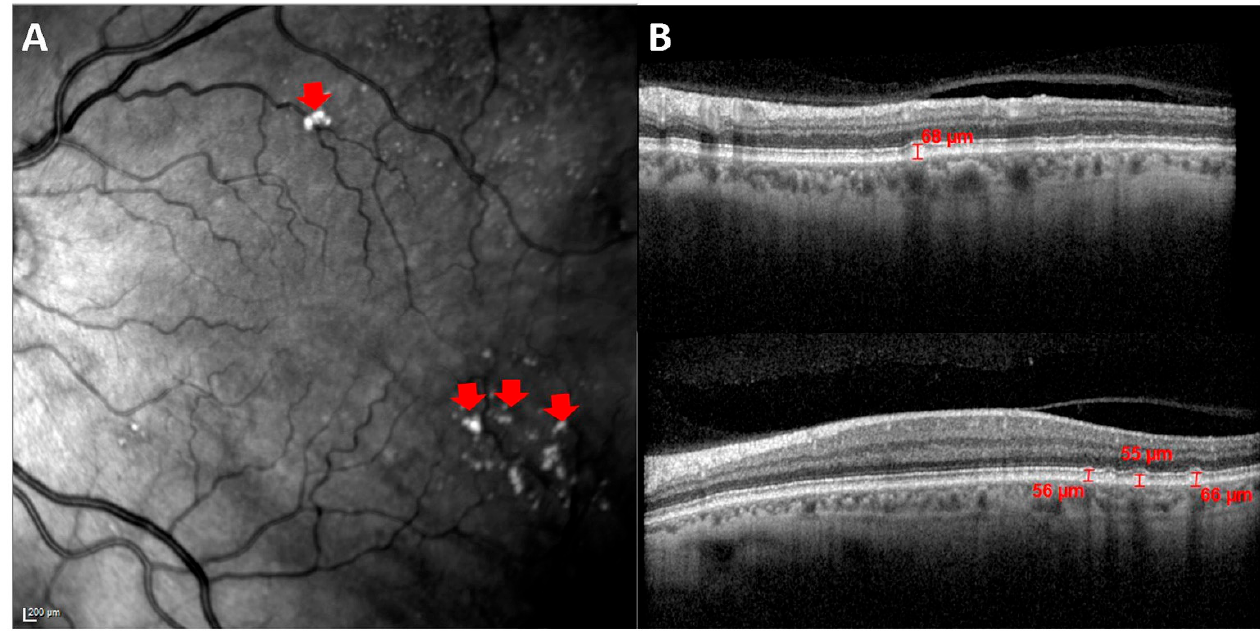
Figure 2. Analysis of drusen by OCT. ( A ) HRA fundus image. The red arrows show hyperreflective shapes. ( B ) Cross-sectional OCT scans showing drusen measurements in µm. This accumulation of hyperreflective material is located between the basal lamina of the RPE and the inner collagen layer of Bruch’s